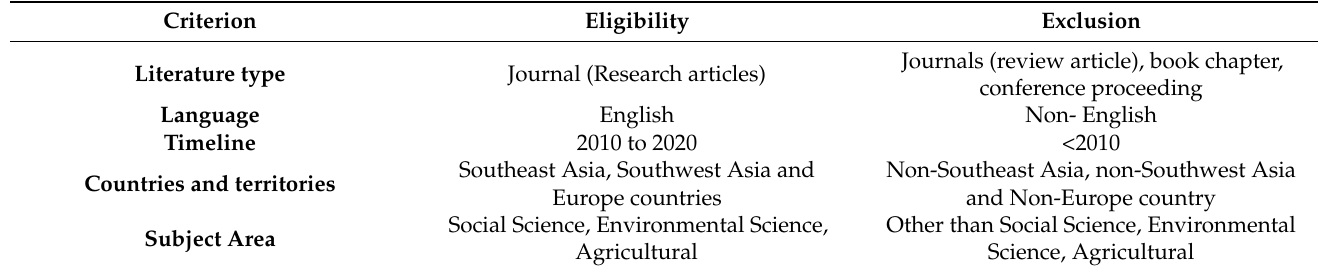
Table 4. Inclusion and Exclusion